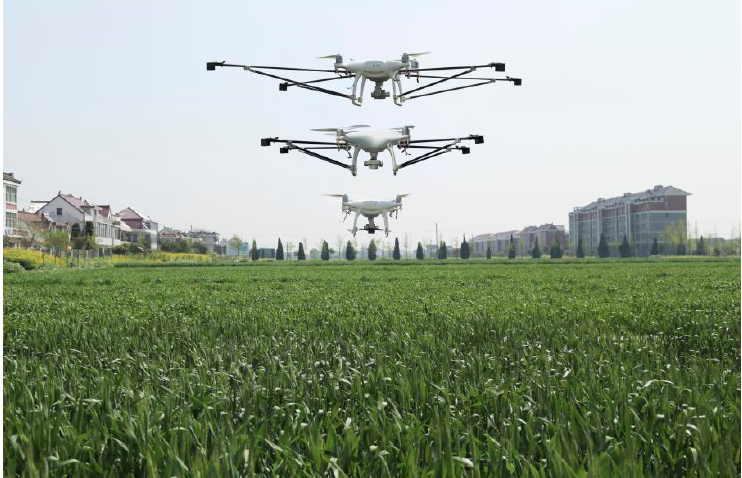
Figure 10. Comparison of field flights with the conditions of three support lengths.